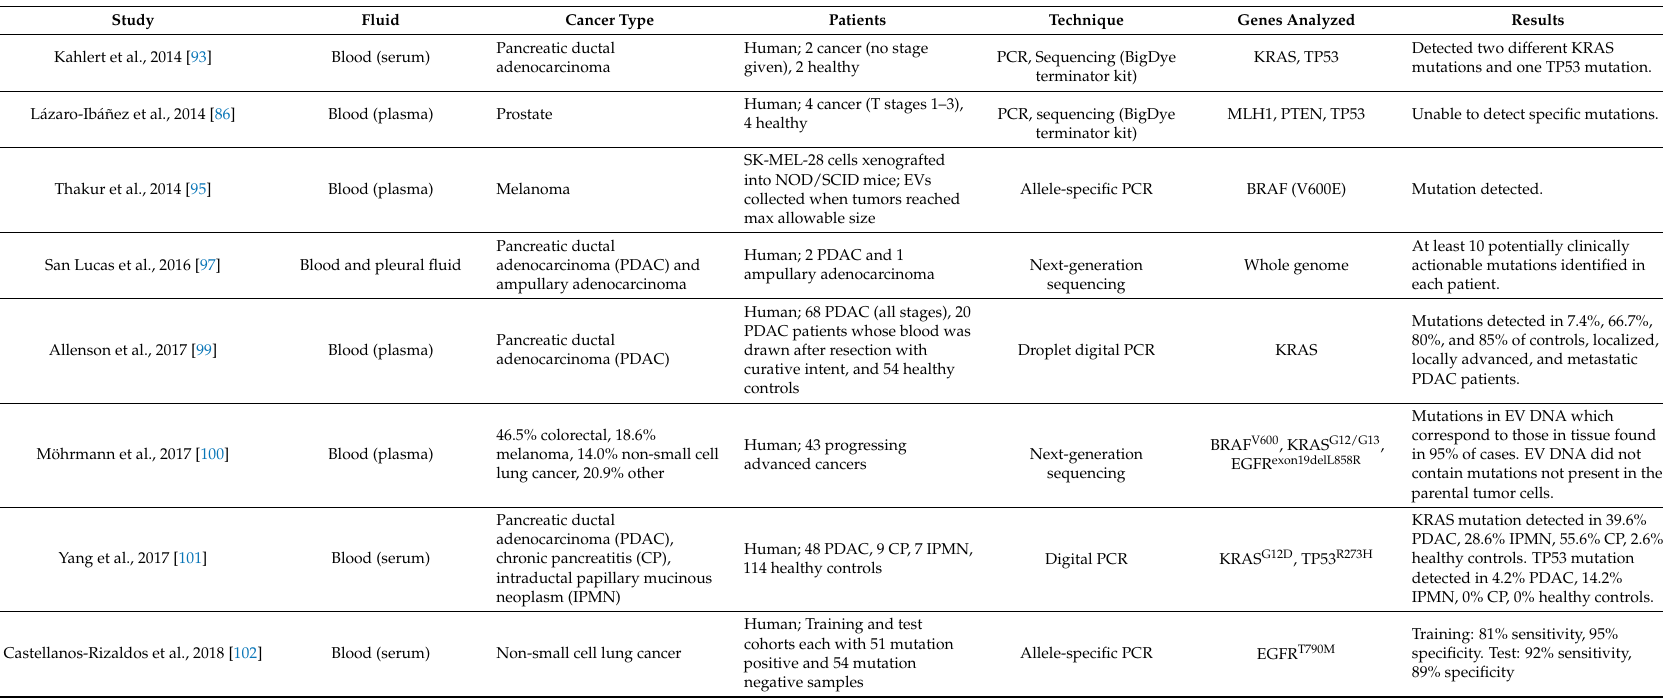
Table 1. Summary of recent publications using EV DNA for detection of specific mutations in cancer-related